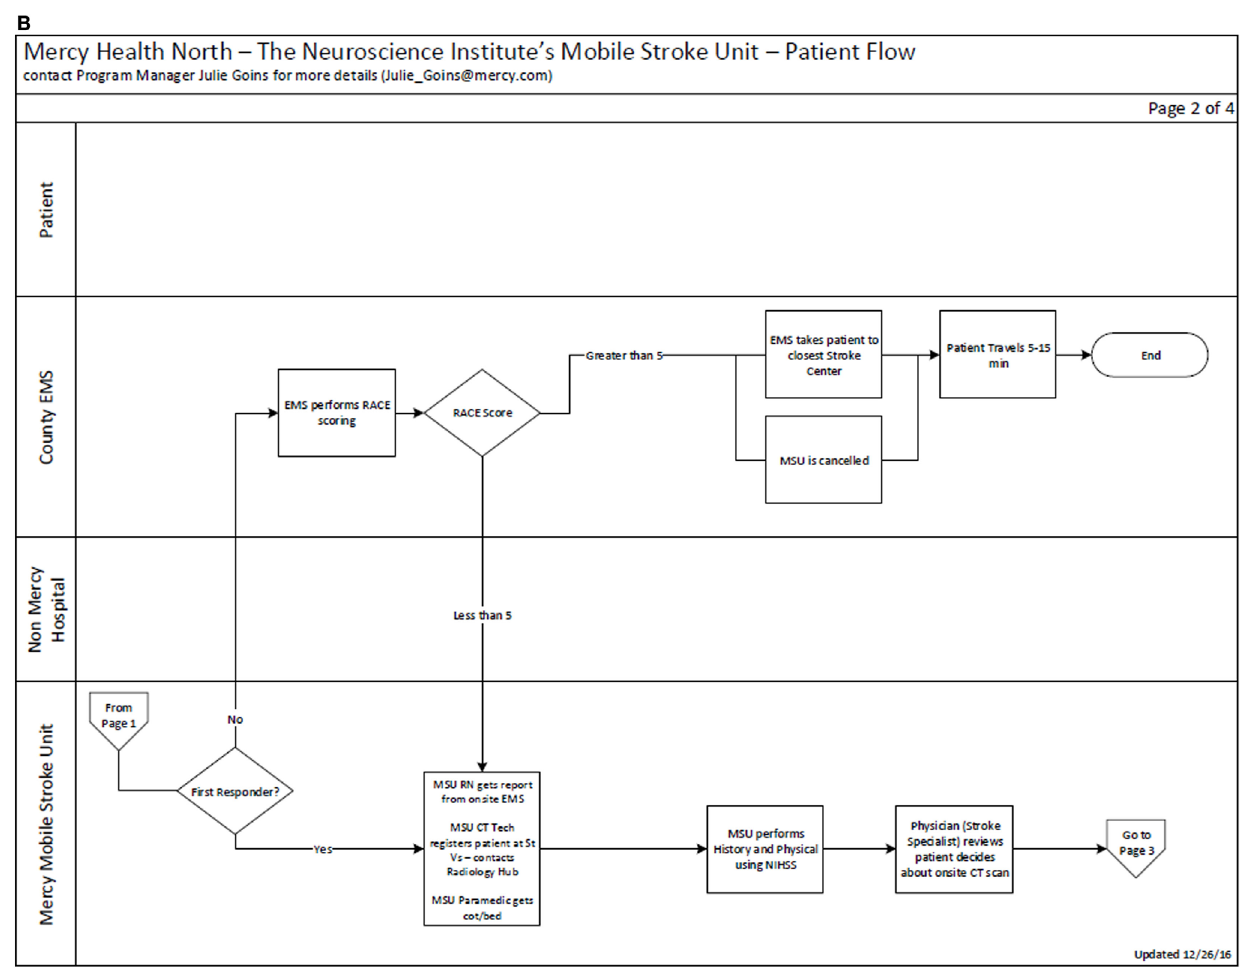
FigUre 1 | (a) Mercy Health Mobile Stroke Unit (MSU) workflow and triage algorithm from activation. (B) Mercy Health MSU activation and triage algorithm part